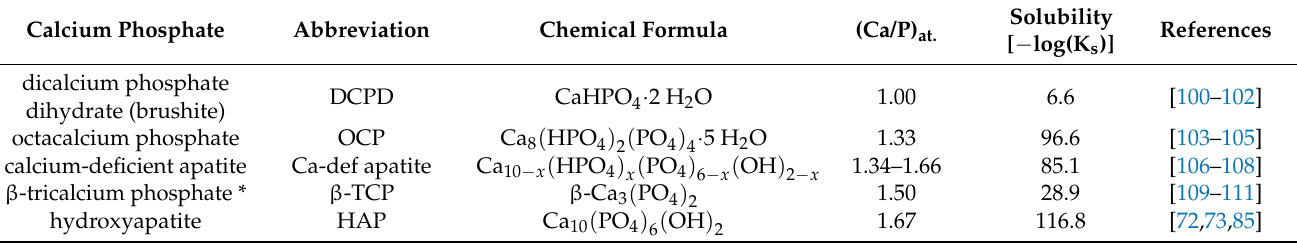
Table 1. Calcium phosphate coatings produced by